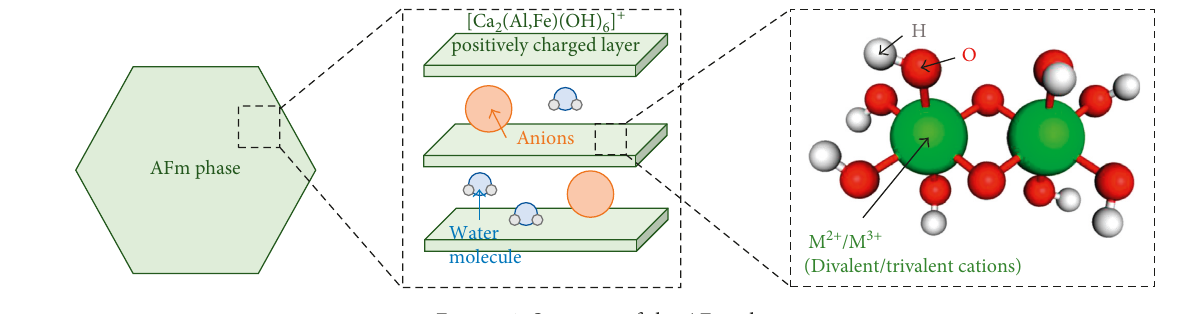
Figure 1: Structure of the AFm phase. Table 1: Oxide composition of Portland cement.